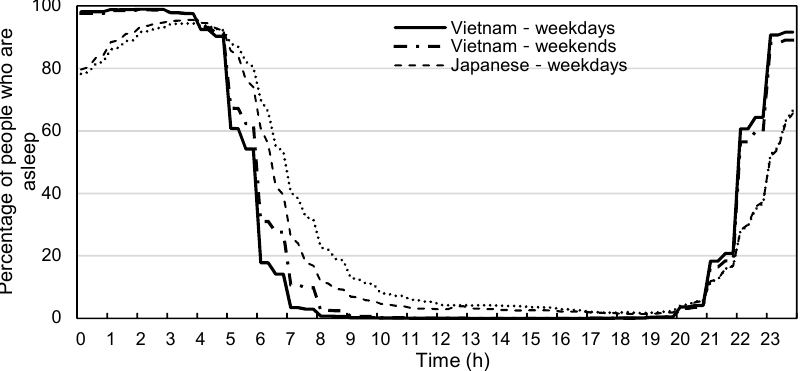
Figure 10. Comparison of sleeping temporal pattern between Japanese and Vietnamese respondents.